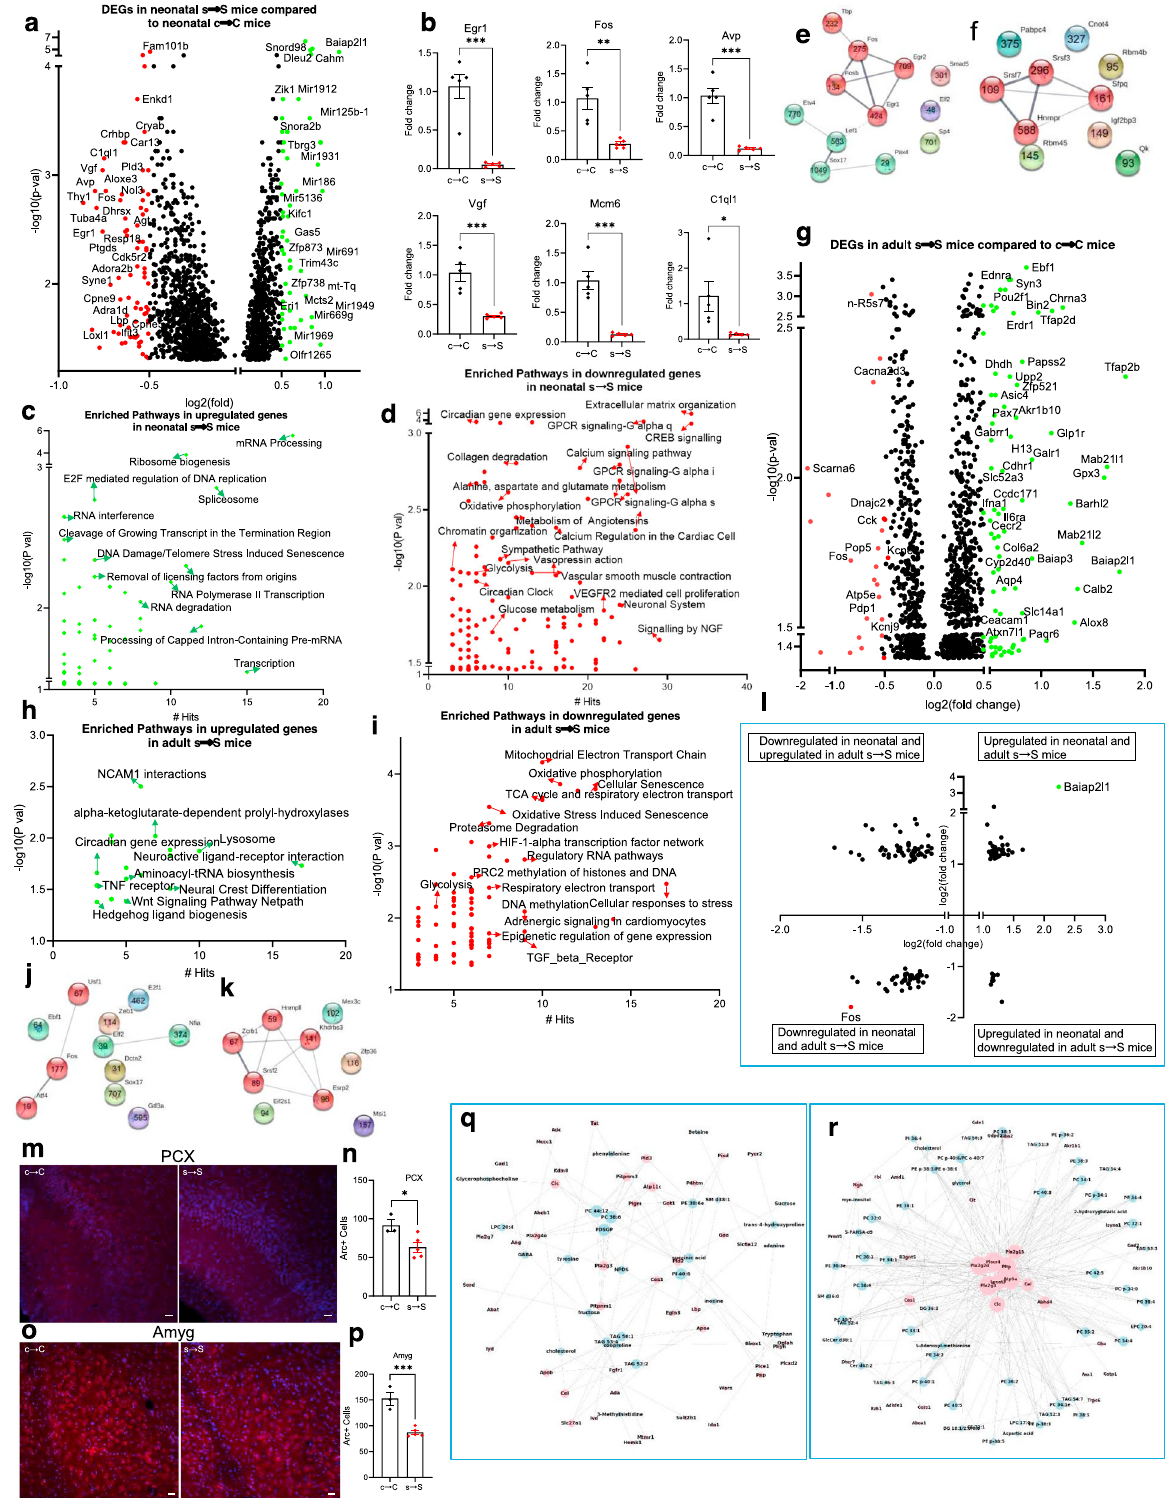
molecular functions enrichment analysis identi fi ed enzymatic activities of 2-ketoglutarate-dependent dioxygenase, phospholi- pase, and cytidine deaminase (Fig. 3q, r, Supplementary Data 6). The linkage analysis of the DEGs with the changes in metabolite levels in the adult pups revealed master pathways including chromatin modi fi cation, lipid metabolism, and glutamate